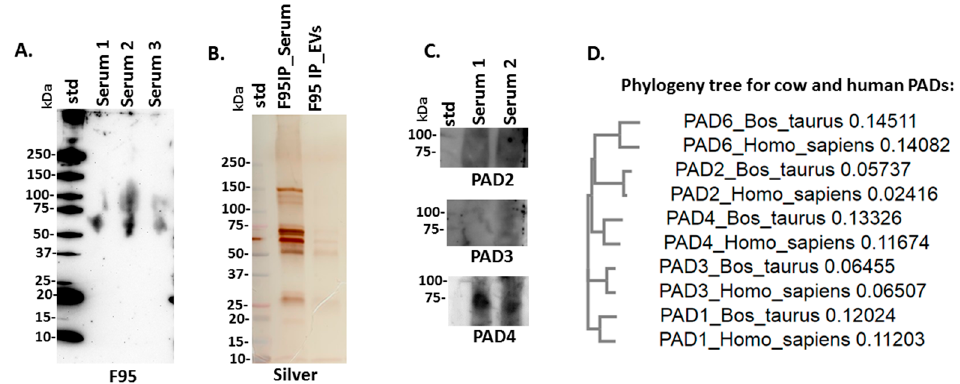
Figure 2. Deiminated proteins and peptidylarginine deiminases (PADs) in bovine serum. ( A ) Total deiminated proteins were identified in bovine serum using the pan-deimination specific F95 antibody. ( B ) F95-enriched IP fraction from bovine serum and serum-extracellular vesicles (EVs), shown by silver-staining. ( C ) Immunodetection of PAD homologues in bovine sera by western blotting, using anti-human PAD2, PAD3 and PAD4 antibodies. ( D ) A neighbor-joining phylogeny tree for bovine and human PAD isozymes.